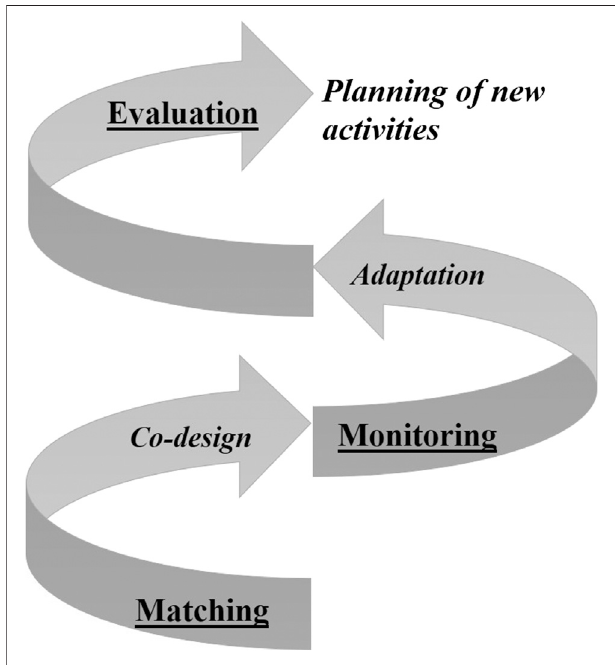
FIGURE 1 | The action research